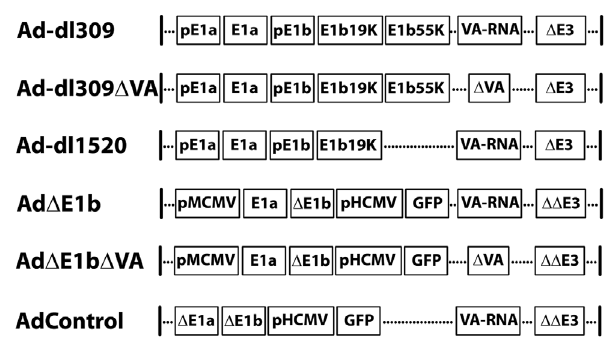
Figure 1. Schematic representation of the adenoviral genomes used in this study. Ad-dl309 encodes both E1a and E1b genes including their respective Ad promoters (pE1a and pE1b, respectively). The virus has a deletion in the E3 region spanning 30005–30750 bp [81]. Ad-dl309 D VA and Ad-dl1520 have additional deletions in the VA- RNA genes (10667–10702 bp as well as 10929–10943 bp) or in the E1b- 55K gene, respectively. Ad D E1b, Ad D E1b D VA and AdControl ( D E1a D E1b) were constructed using the AdEasy-1 system and the